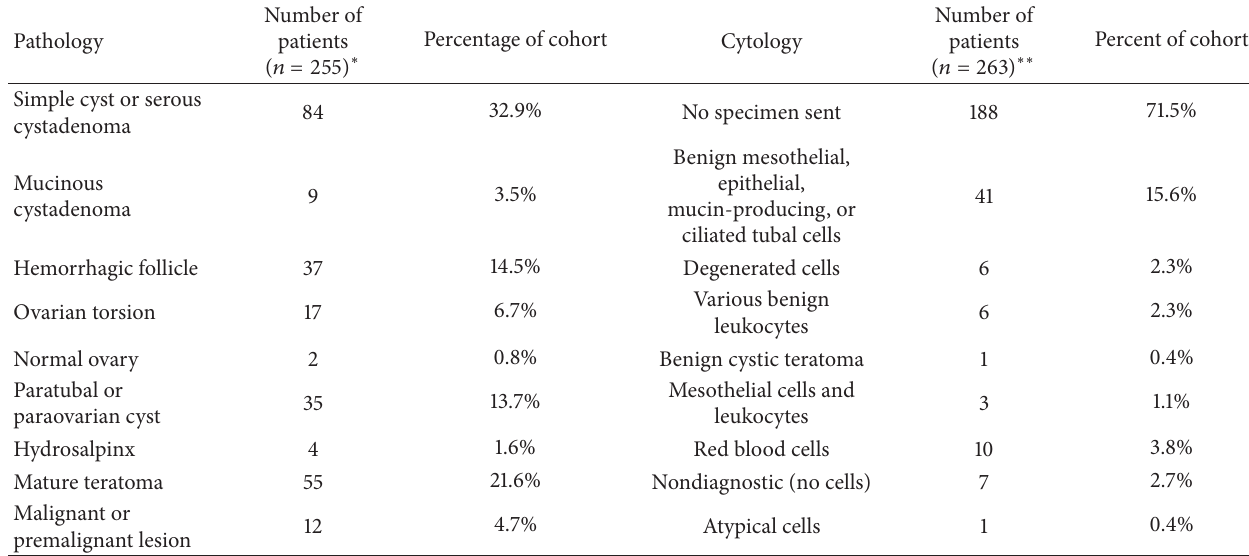
Table 3: Surgical pathology and cytology